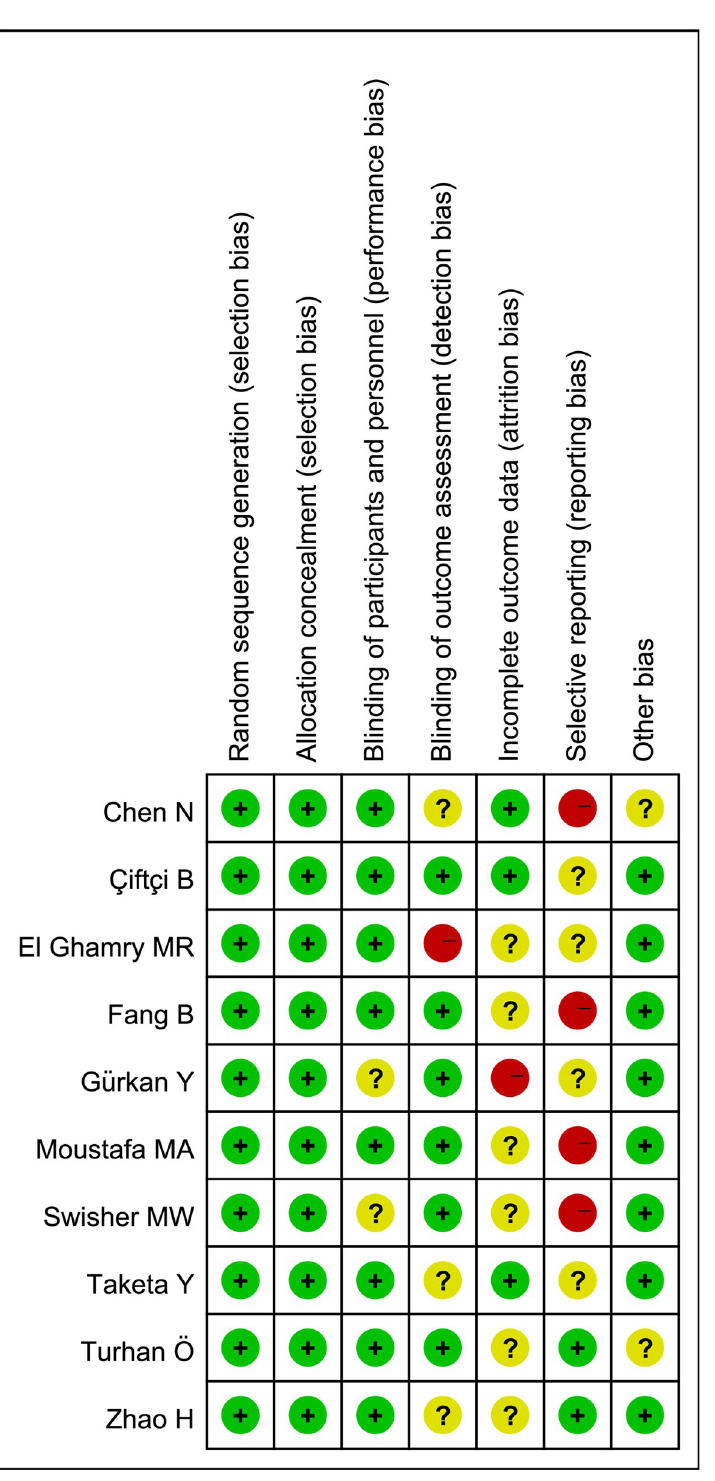
Fig 2. Risk of bias assessment using Cochrane